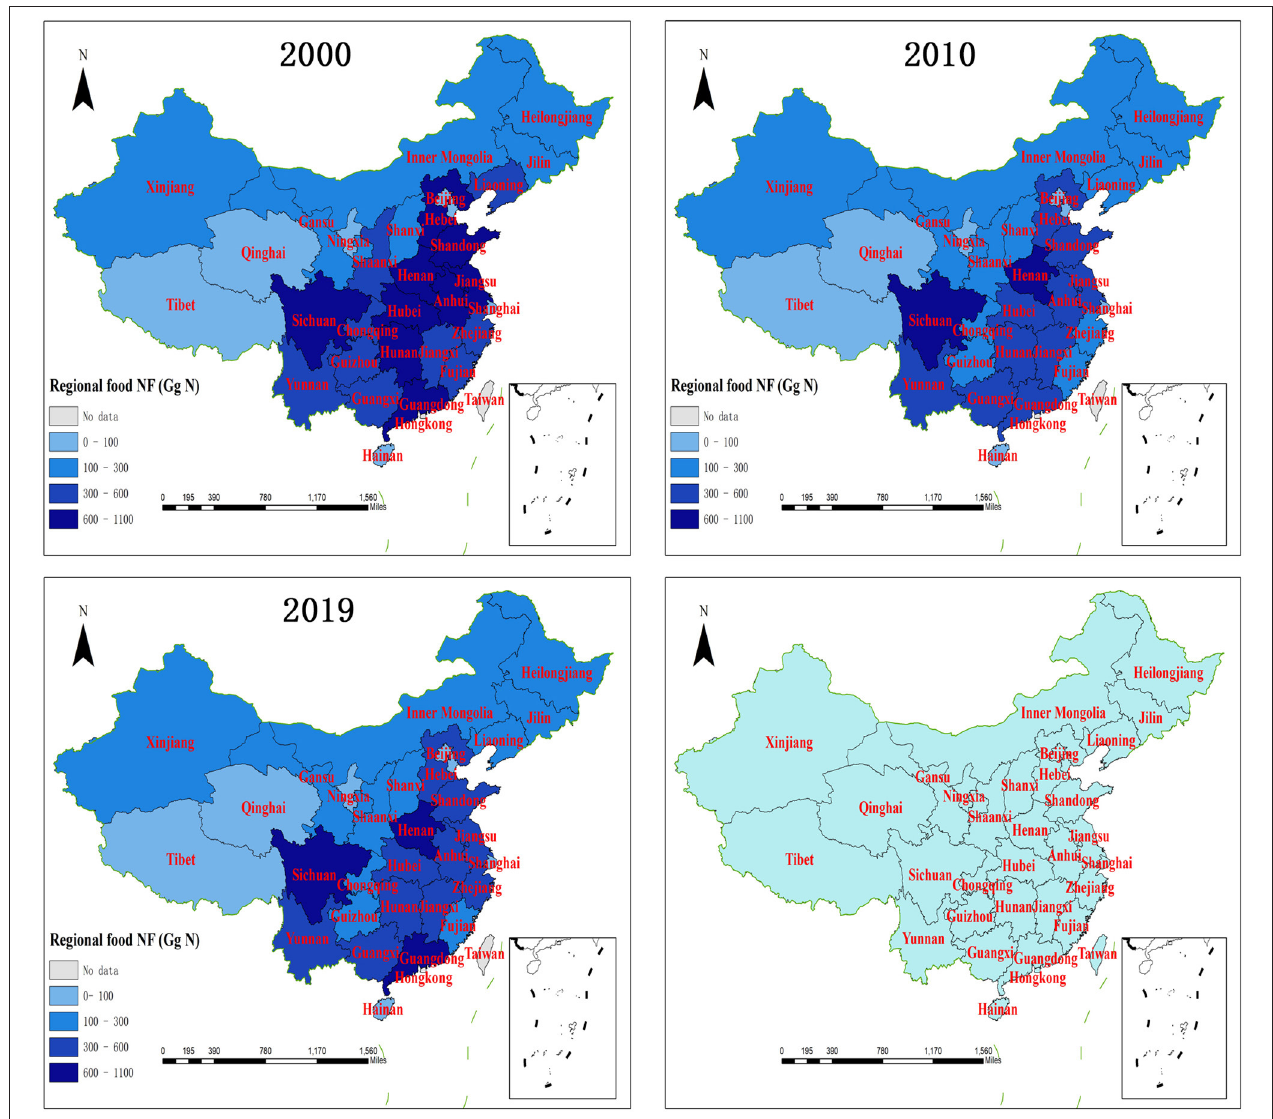
FIGURE 2 | Spatial distribution of regional food NFs from 2000 to